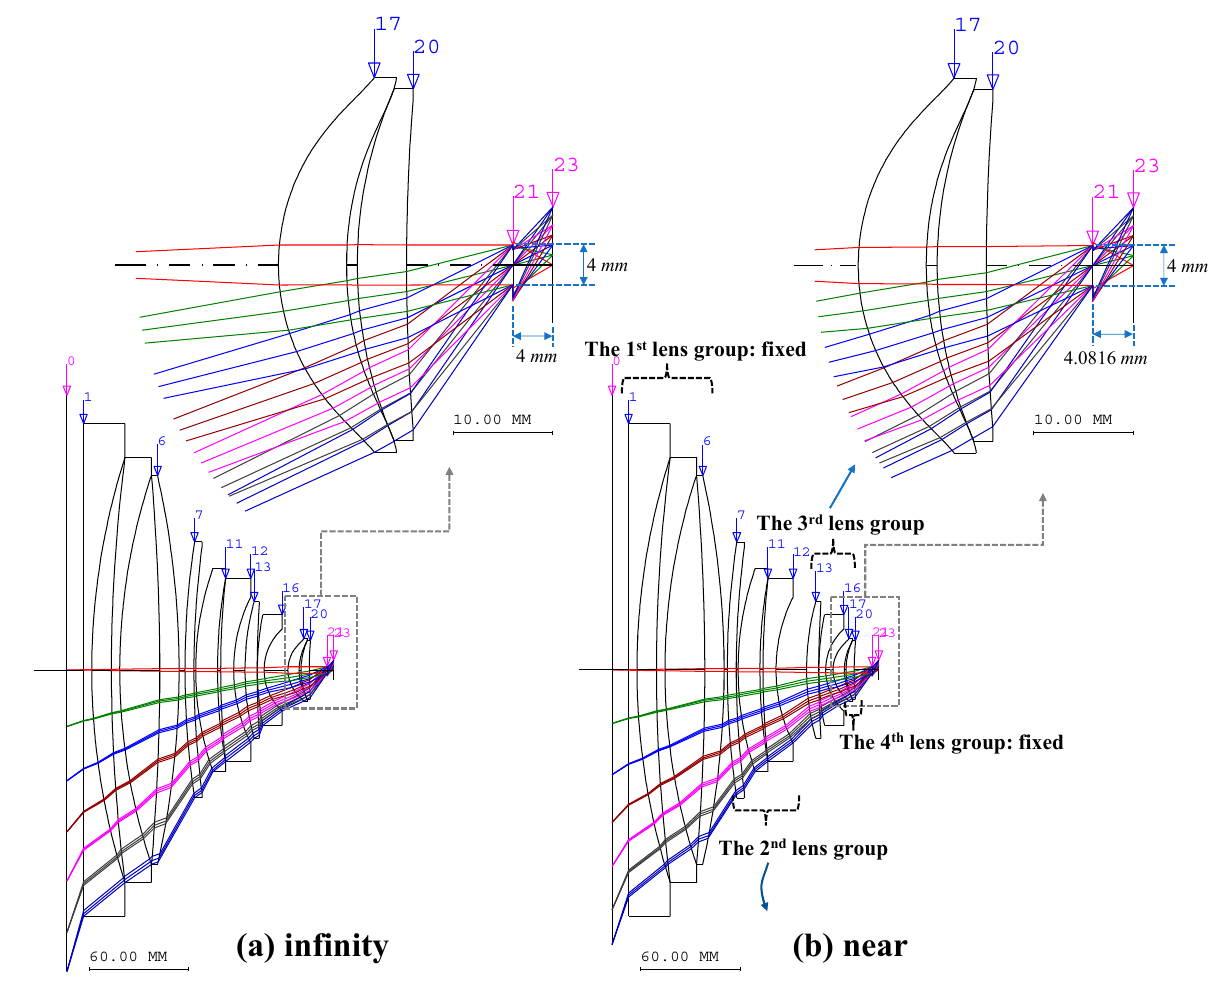
Figure 3. Optical layout for the final design.